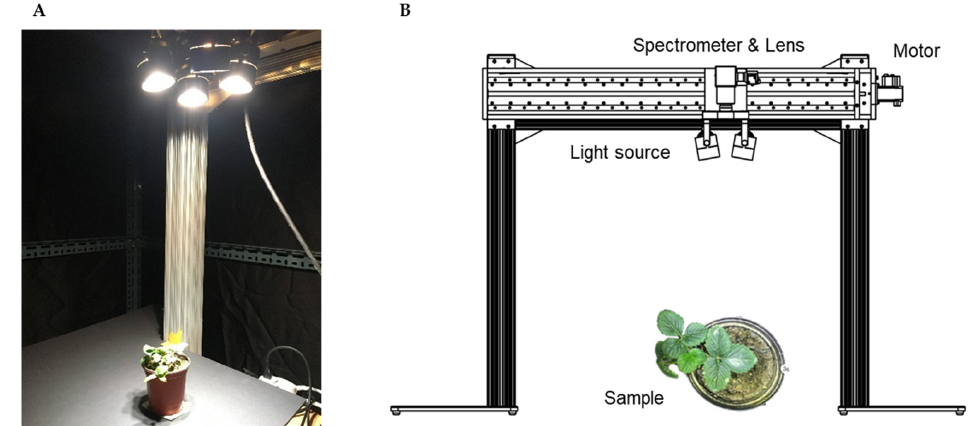
Figure 1. Hyperspectral imaging system designed for crop phenotyping: ( A ) hyperspectral image lab dark room environment and ( B ) system overview.